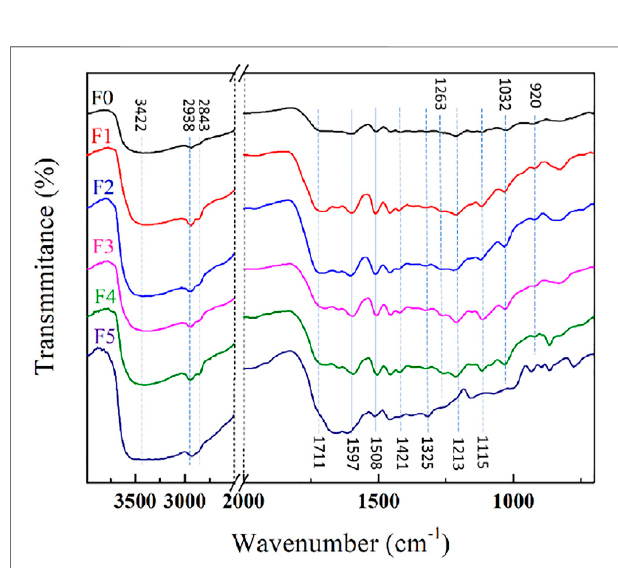
FIGURE 2 | FTIR spectra of tobacco stalk lignin and fractionated lignins.